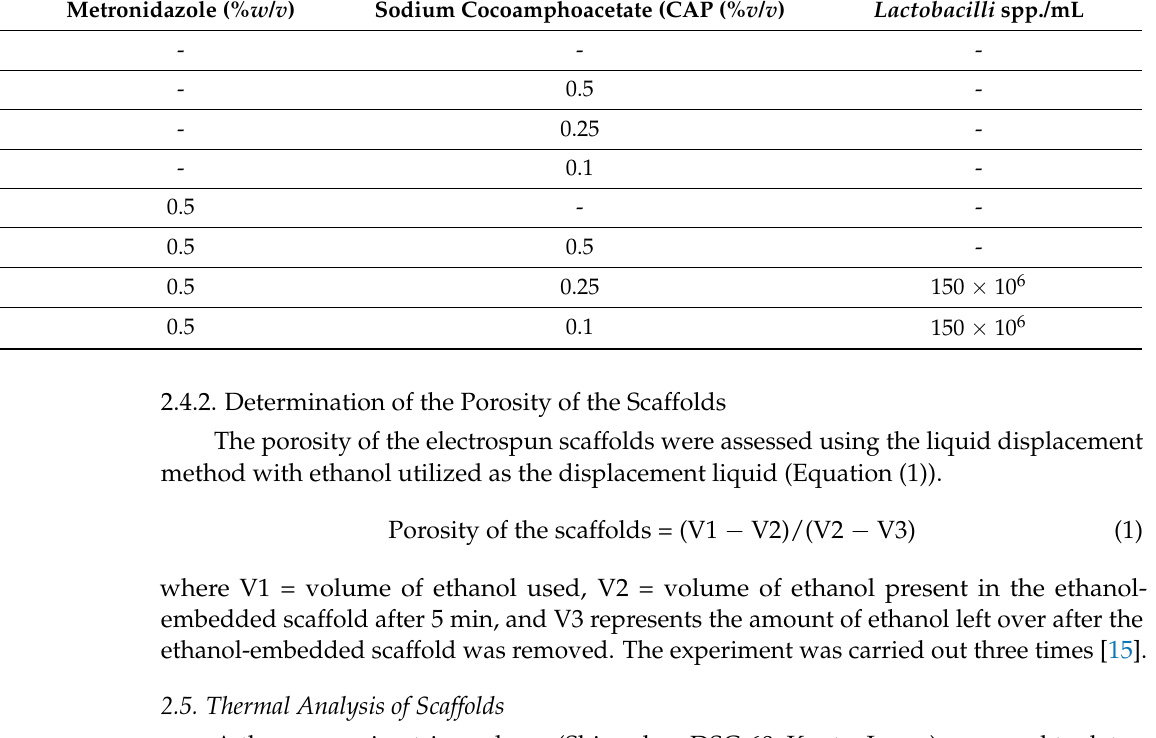
Table 1. Formulation design for electrospinning solutions PVA/PCL. Formulation Metronidazole (% w / v